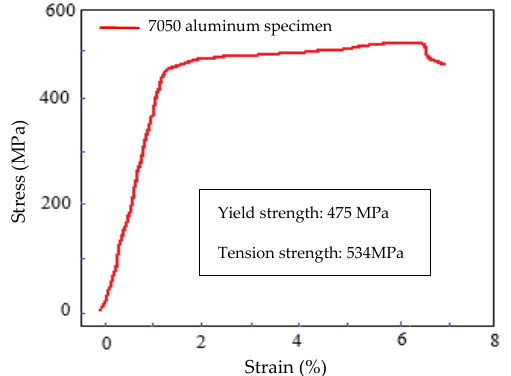
Figure 3. Stress – strain curve of aluminium alloy 7050. Figure 3. Stress–strain curve of aluminium alloy